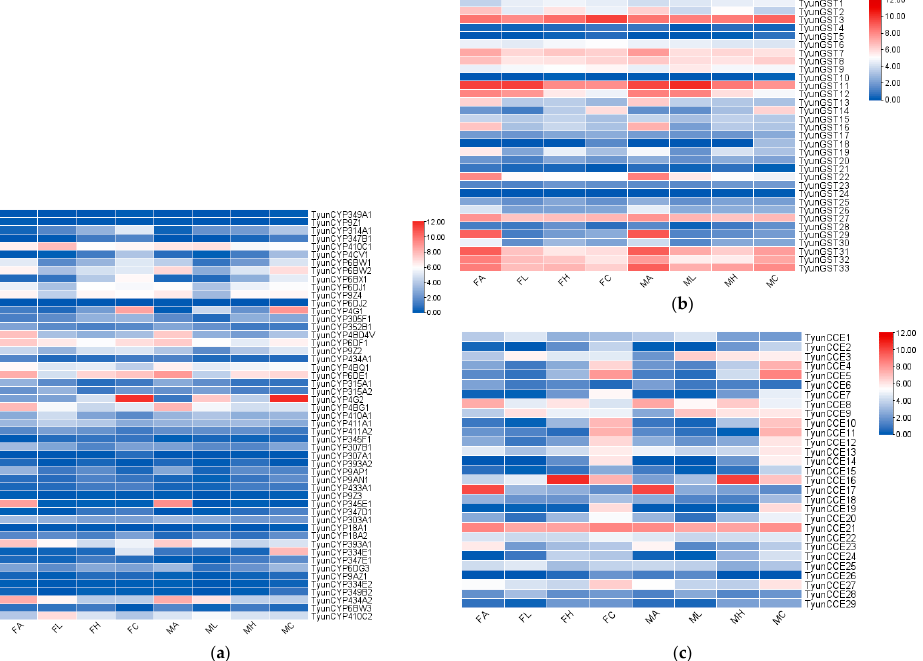
Figure 6. Expression profiles of detoxification genes in T. yunnanensis . ( a ) CYP; ( b ) GST; ( c ) CCE. MA: male antennae, MH: male head, ML: male legs, MC: male carcasses, FA: female antennae, FH: female head, FL: female legs, FC: female carcasses.